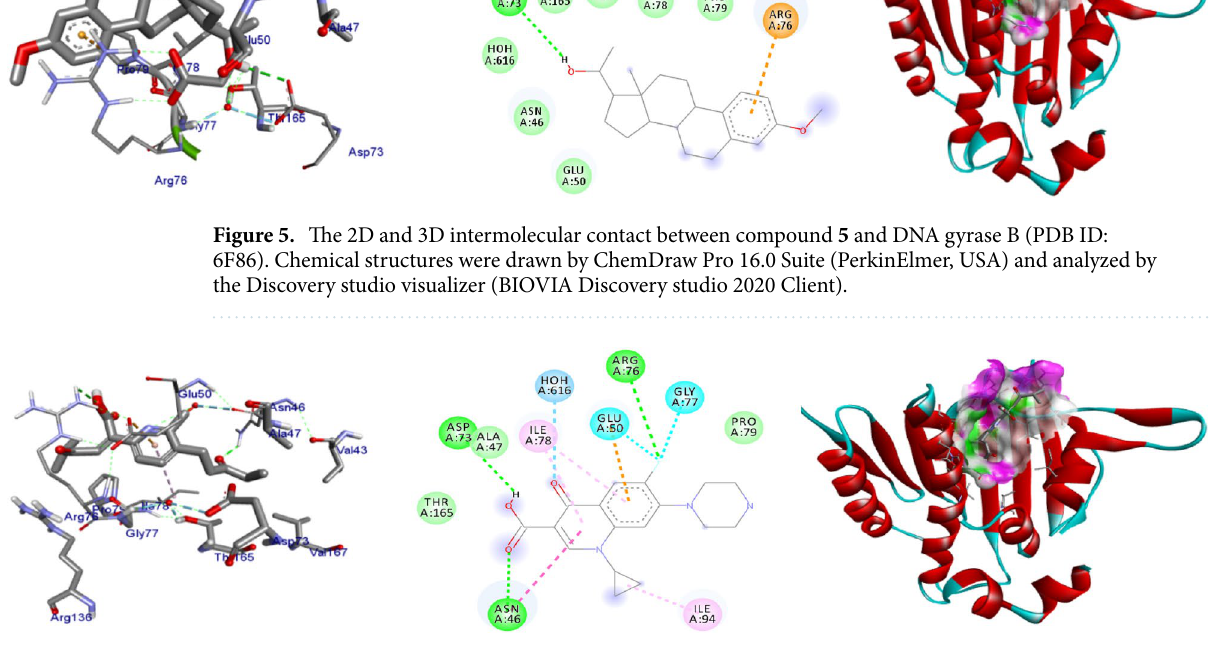
Figure 6. The 2D and 3D intermolecular contact between ciprofloxacin and DNA gyrase B (PDB ID: 6F86). Chemical structures were drawn by ChemDraw Pro 16.0 Suite (PerkinElmer, USA) and analyzed by the Discovery studio visualizer (BIOVIA Discovery studio 2020